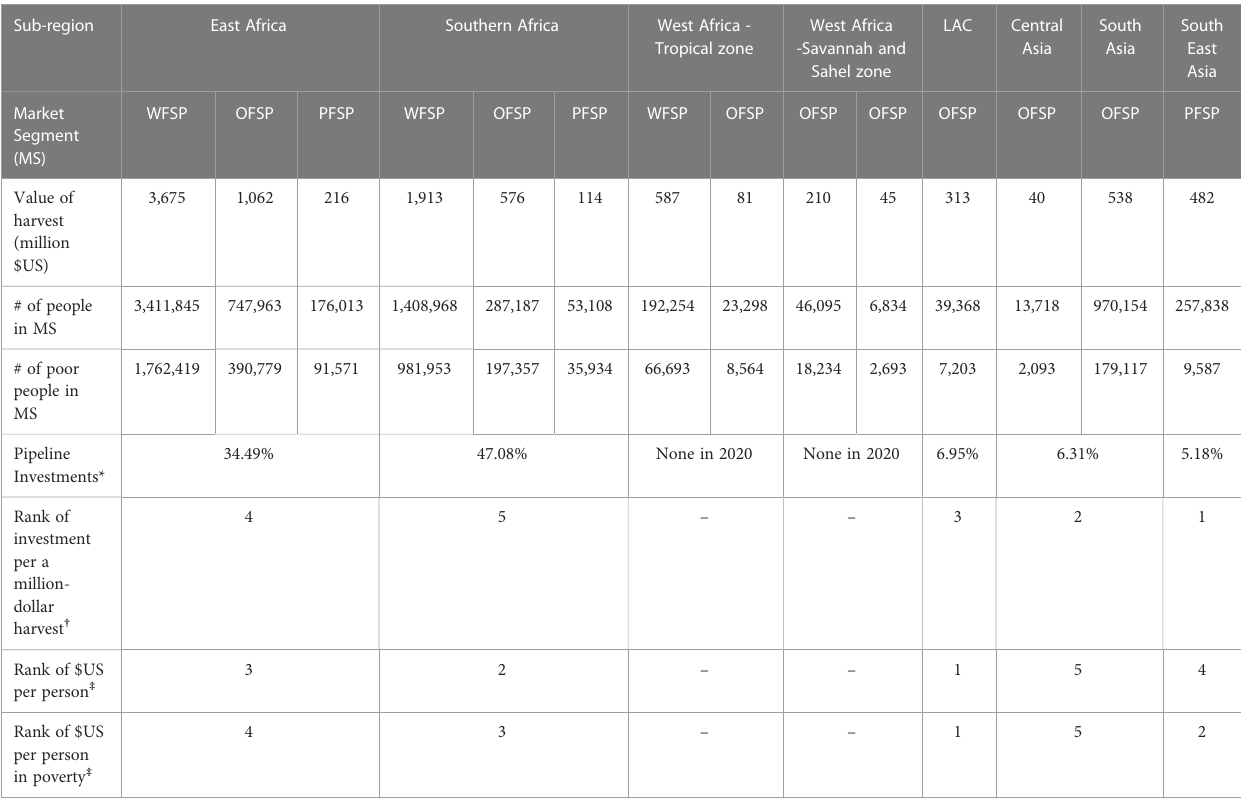
TABLE 3 Size of sweetpotato market segments and potential poverty impact in the pipelines.